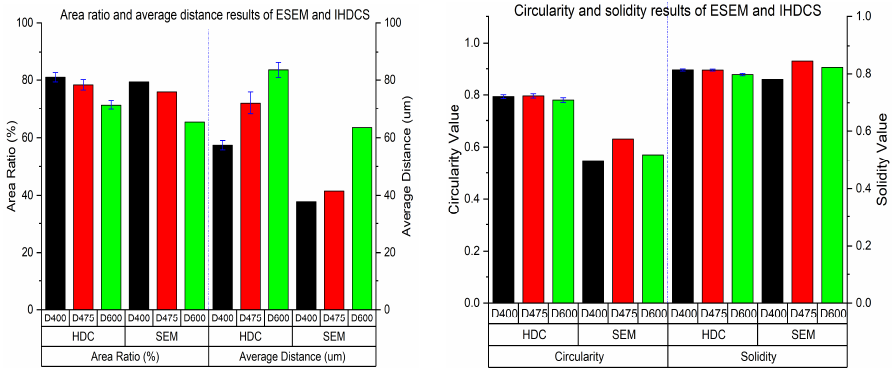
Figure 12. Comparative analysis of physical parameter results between ESEM and IHDCS.